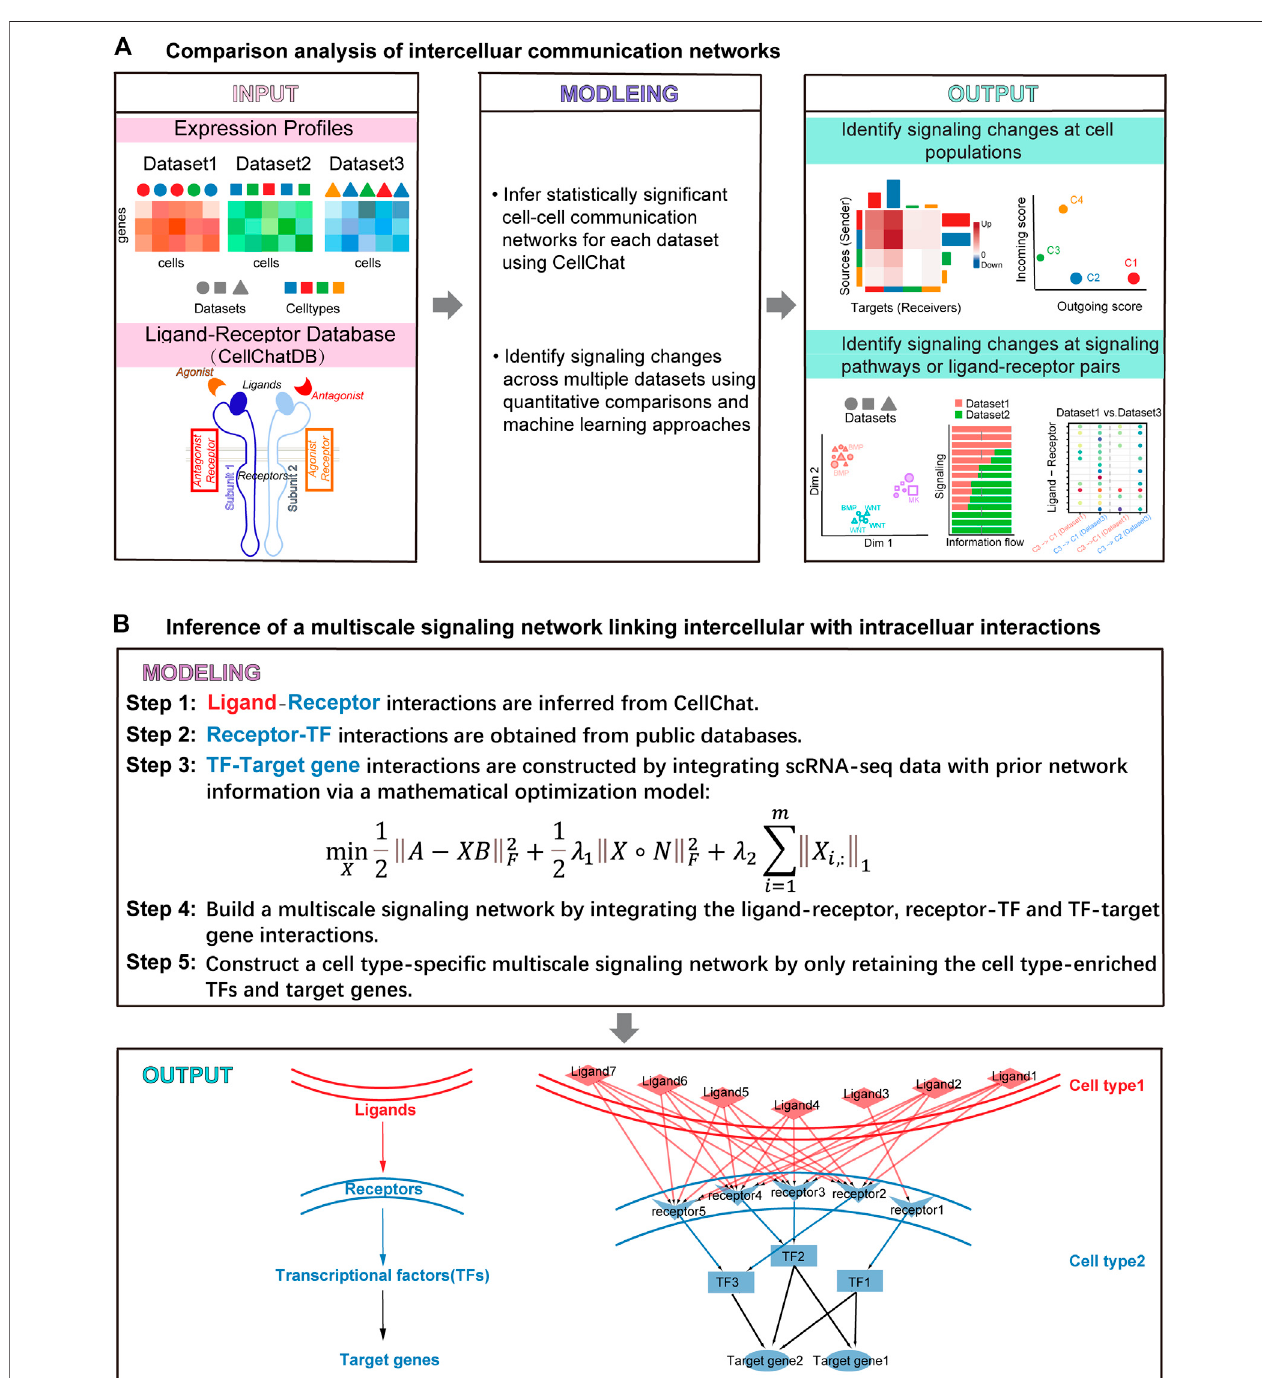
FIGURE 1 | Overview of identifying intercellular signaling changes across conditions and inferring the multiscale signaling network from multiple scRNA-seq datasets. (A) The generalized CellChat identi fi es intercellular signaling changes across conditions from multiple scRNA-seq datasets. CellChat requires the users to provide multiple datasets with cell type labels as input, where the cell types of different data sets may not be exactly the same. CellChat identi fi es biologically signi fi cant signalingpathwaysforeachdatasetseparatelyandthenperformscomparativeanalysisacrossmultipledatasetsinasystematicandquantitativemanner.CellChat identi fi es signaling changes across multiple datasets in terms of cell types and signaling pathways or ligand receptor pairs. Different plots are provided to allow ready comparison analysis. (B) Multiscale signaling network is inferred to link intercellular communication to intracellular signaling, which integrates the ligand – receptor interactions, receptor-TFs interactions, and TFs-target gene interactions.